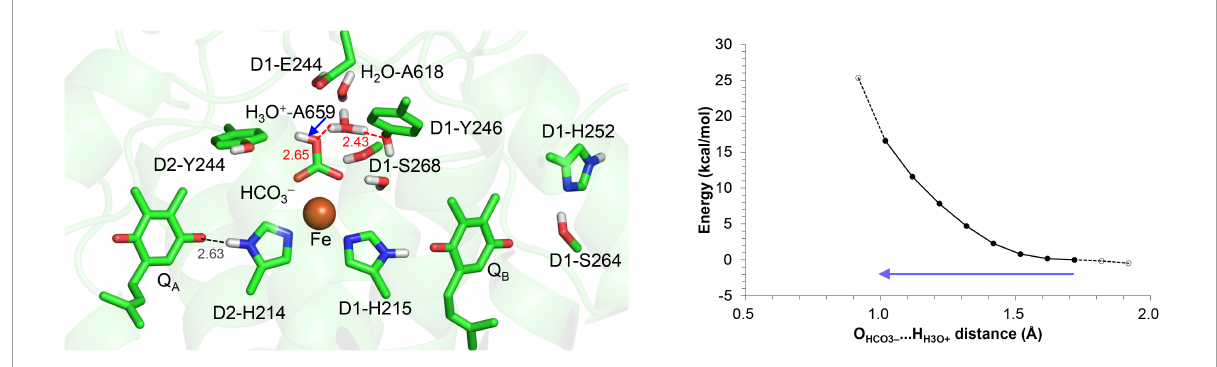
FIGURE5 Potential energy profile for proton transfer from H 3 O + at D1-Ser268 to the bicarbonate ligand. The blue arrow indicates the orientation of the proton transfer. Note that the geometry of each intermediate conformation is fully QM/MM